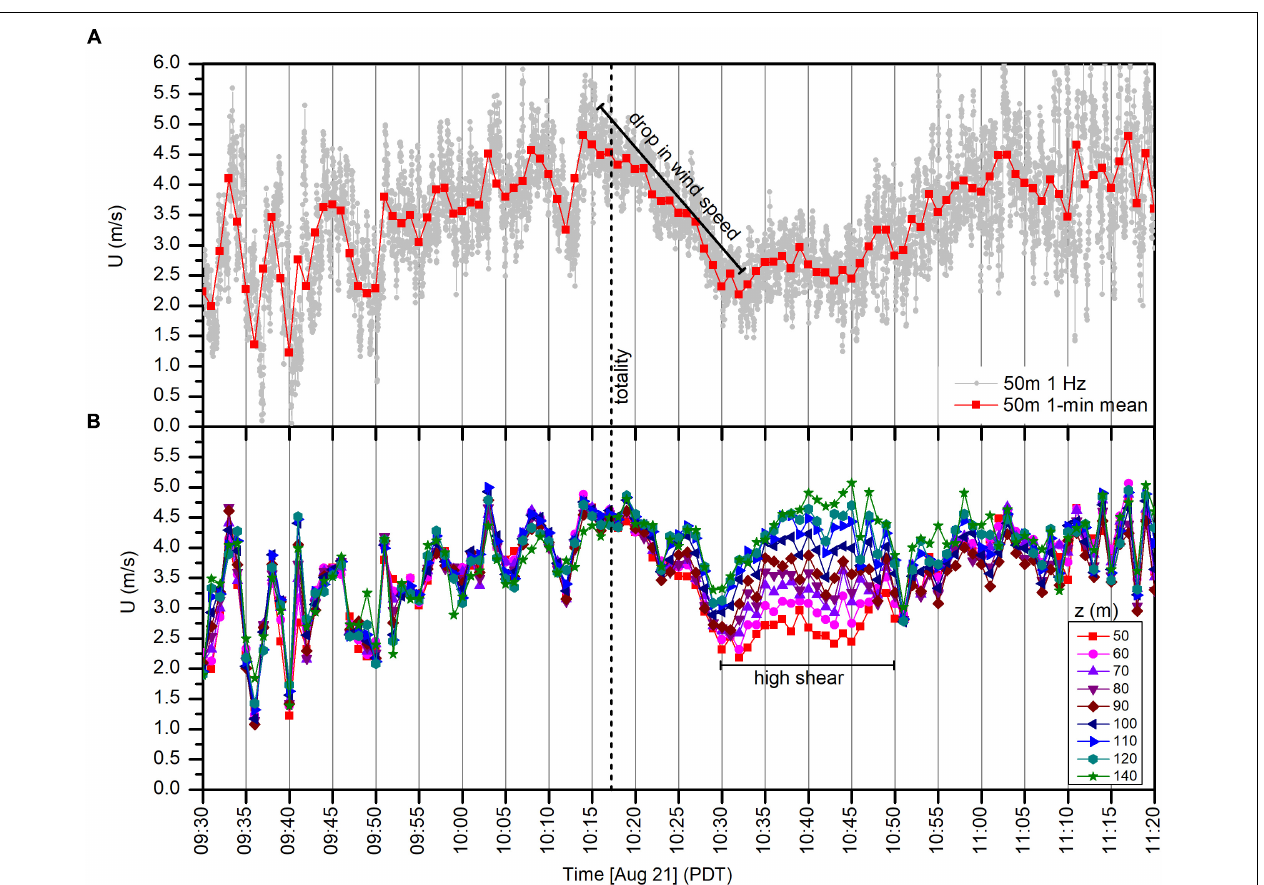
FIGURE 6 | A subset of the lidar data illustrating the time lag between totality, the decrease in wind speed, and maximum shear. (A) Data collected at 50 m including the 1 Hz and 1-min averages of wind speed. (B) 1-min averages for all heights between 50 and 140 m.